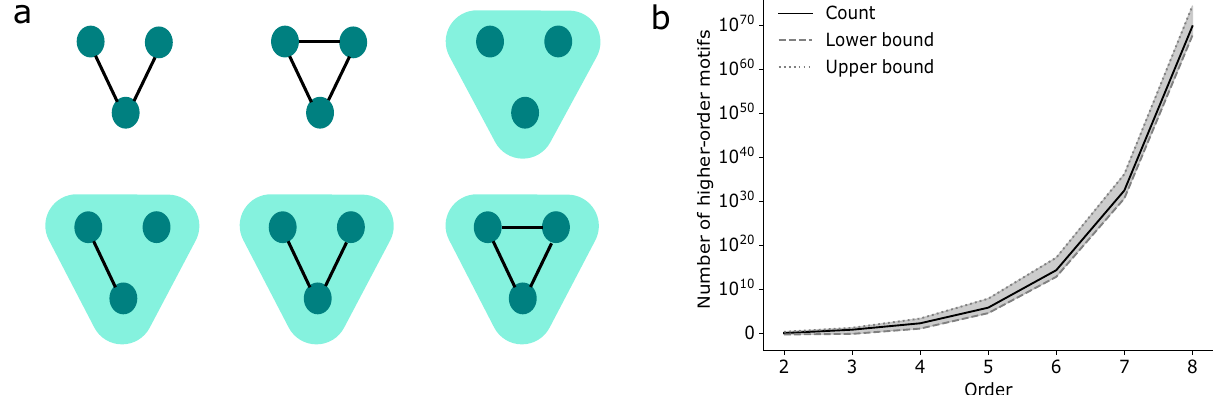
Fig. 1 Combinatorics of higher-order motifs. a Enumeration of all the six possible patterns of higher-order interactions involving three nodes. Green shaded triangles represent higher-order interactions, whereas black lines represent pairwise interactions. b Upper and lower bounds on the number of higher-order motifs as a function of the order (gray shaded area). The black line represents the exact count for small